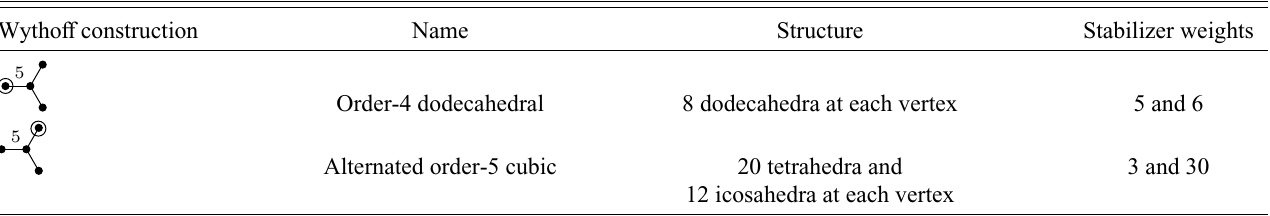
TABLE I. Some of the tessellations that can be constructed from the Coxeter diagram codes defined on these tessellations have the stabilizer weights shown in the fourth